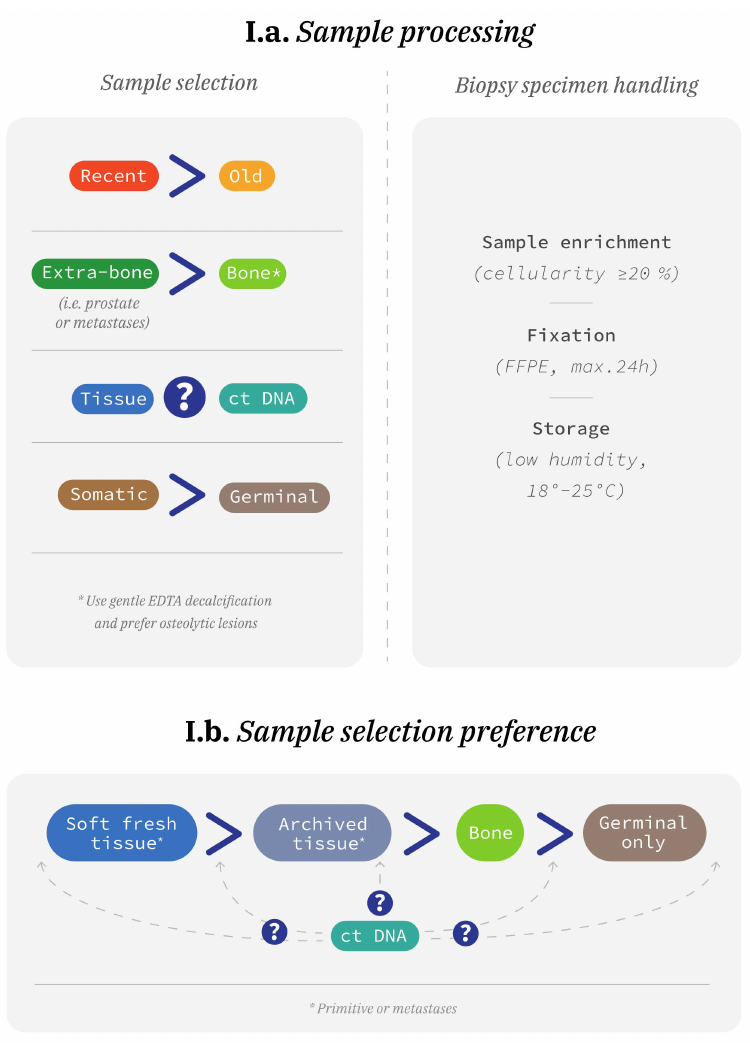
Figure 1. Modality of screening for homologous recombination repair deficiency. ( a ) To improve screening quality, pathologists should favor recent tissue samples, from extra-bone localizations. Germinal screening should be considered only if there is no tumor DNA available. Pathologists should select a tumor area with good cellularity, use a gentle fixation process, and store samples in controlled conditions. ( b ) Where possible, pathologists should use soft fresh tissue rather than archived tissue or bone lesion to determine homologous recombination repair status. Germinal analysis can be considered only in the absence of tumor DNA. Analysis of circulating tumor DNA (ctDNA) is complementary and its role and place in the sequence is yet to be